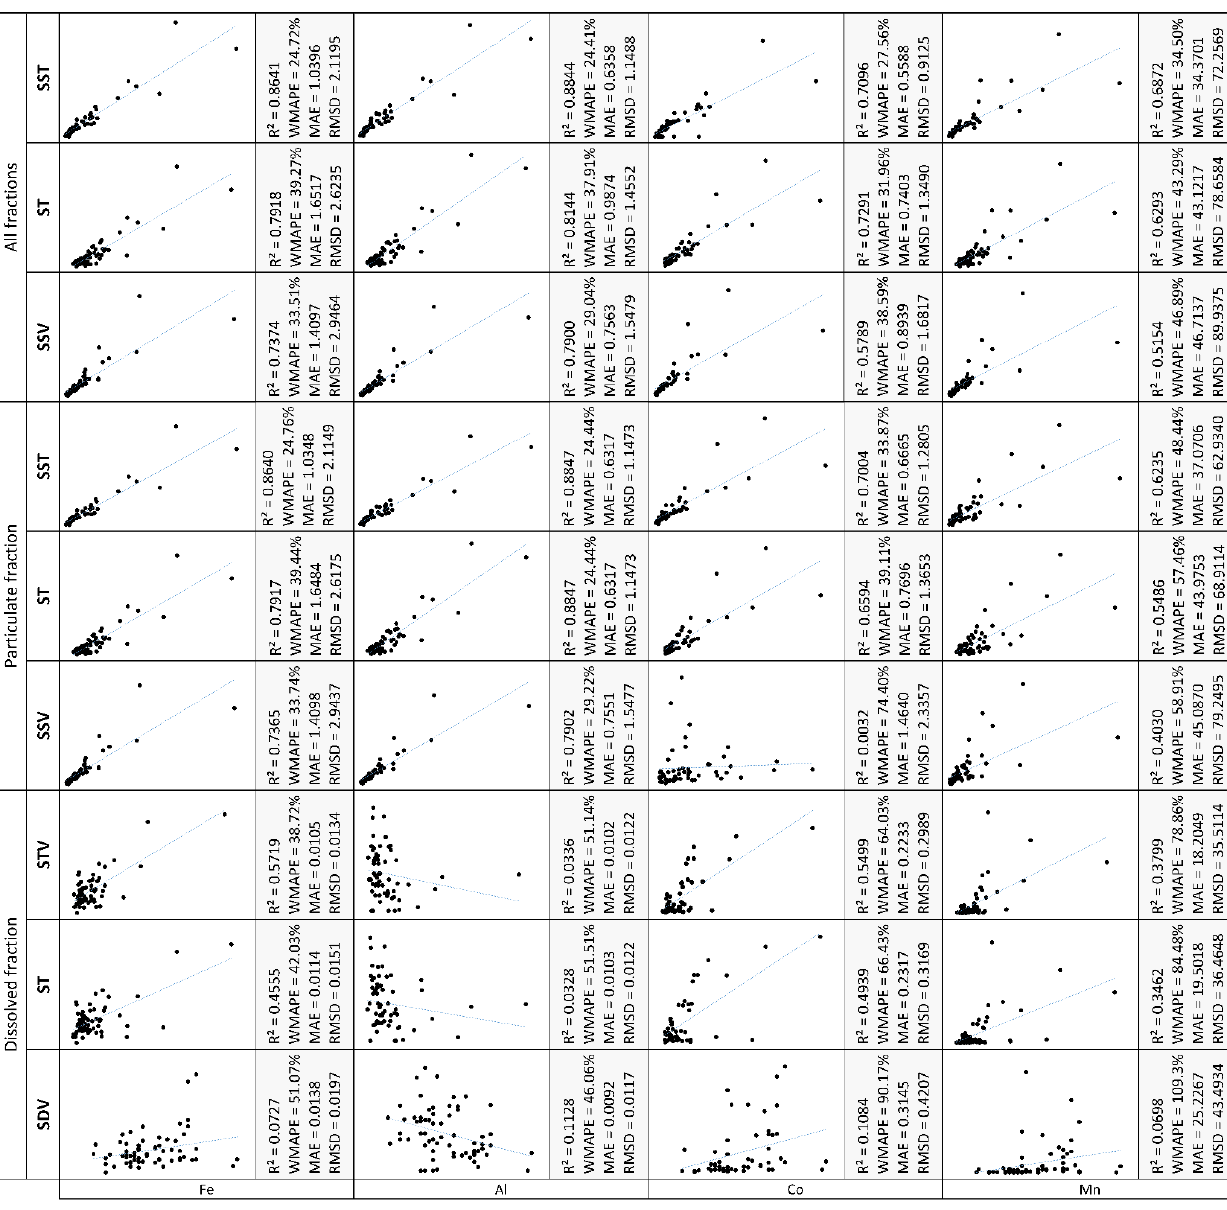
Figure 4. Adjustment statistics of the regression models developed for the surrogate parameters identified in the road runoff. R 2 = Determination coefficient, WMAPE = Weighted mean absolute percentage error, MAE = Mean absolute percentage error, and RMSD = Root mean square deviation.